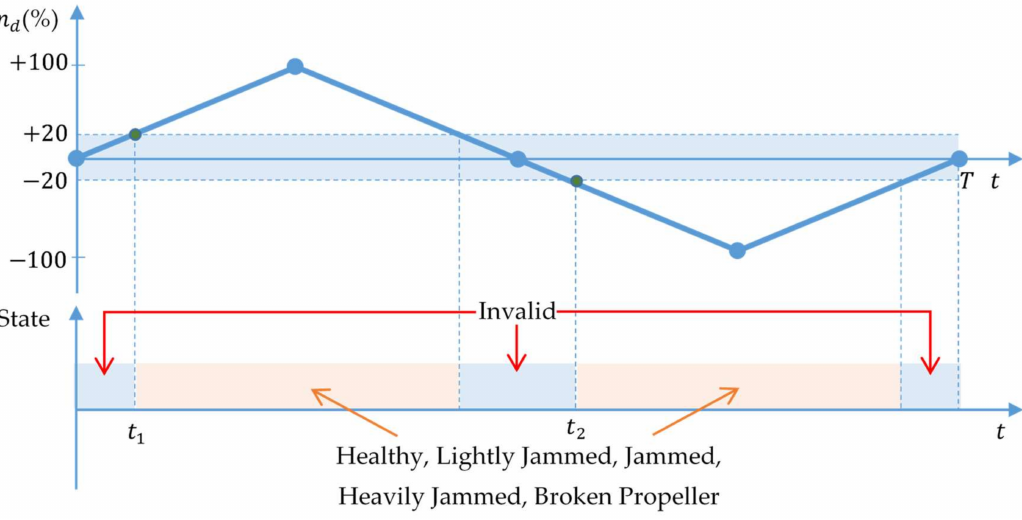
Figure 15. Time responses of command signal and thruster states.